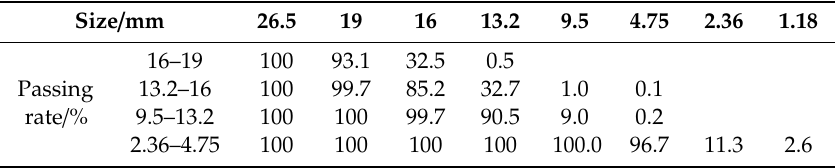
Table 3. Gradations of new